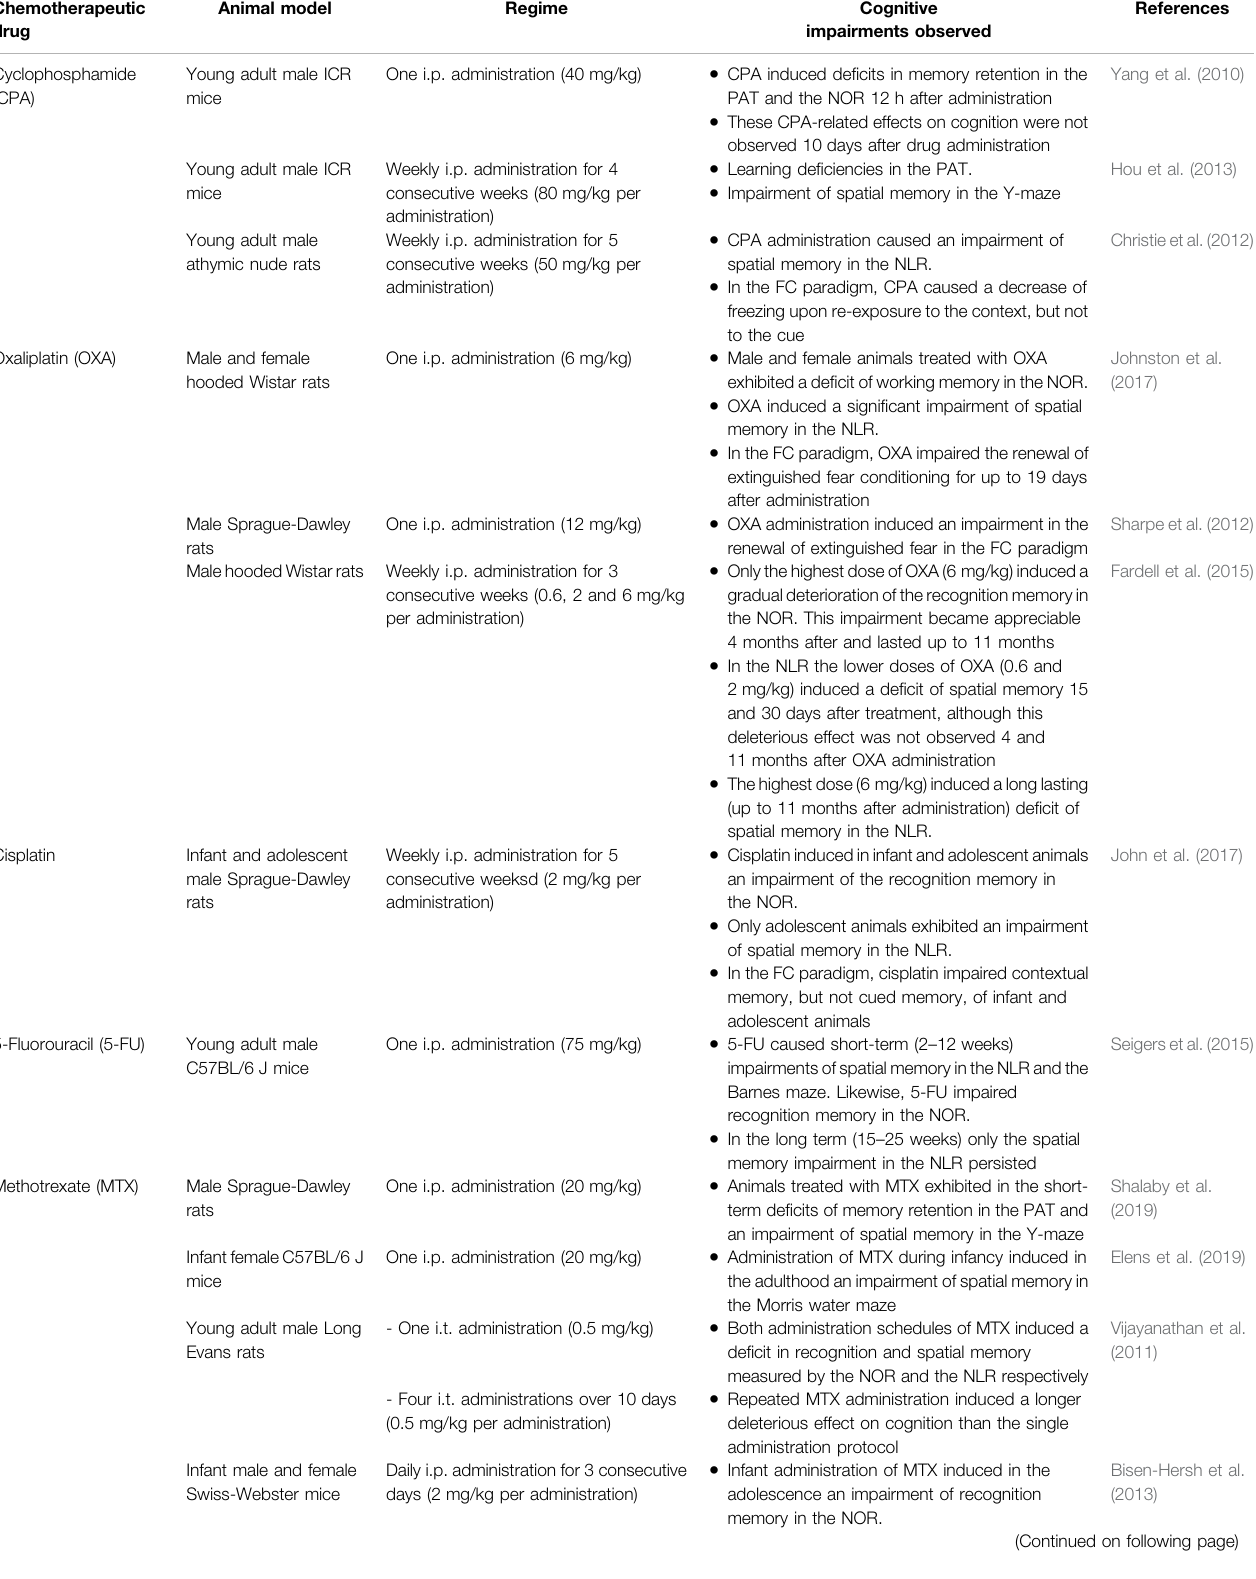
TABLE 1 | Summary of cognitive de fi cits induced by chemotherapeutic drugs in preclinical animal models of chemotherapy-induced cognitive impairment (CICI). Chemotherapeutic